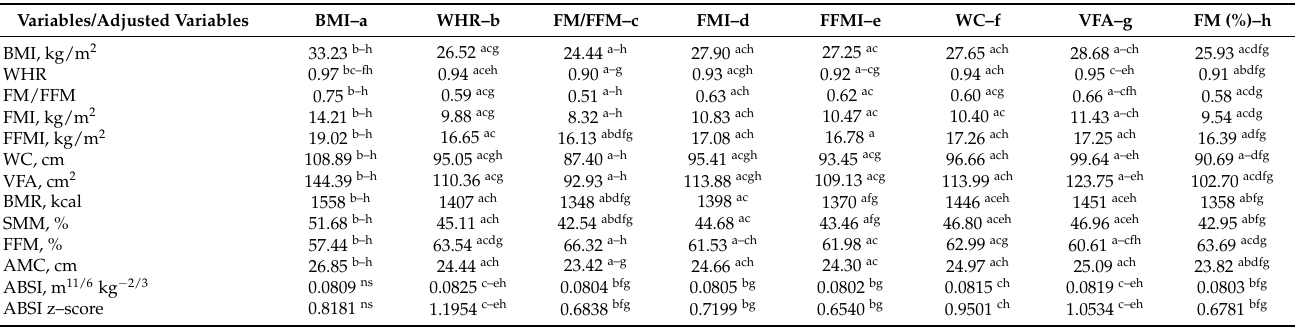
Table 5. Assessment of variables in groups of young women defined as obese according to different anthropometric parameters and indices